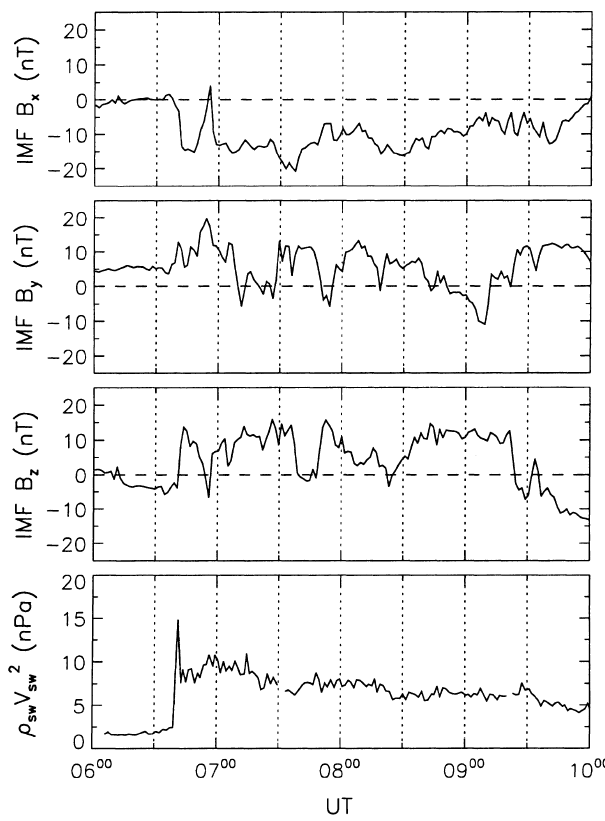
Fig. 1. Time series of IMF components B wind dynamic pressure, as measured by the MFI and SWE instruments on Wind, from the interval 0600 UT to 1000 UT, 26